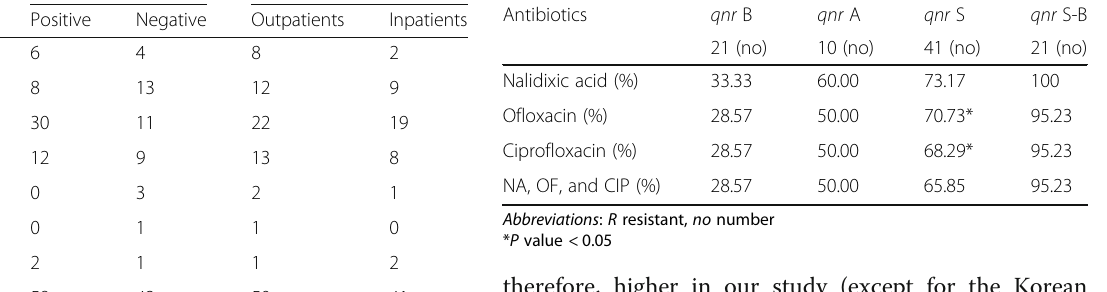
Table 3 Frequency of different qnr genes, among ESBL pos, ESBL neg, and outpatients and inpatients Qnr A,B, and S